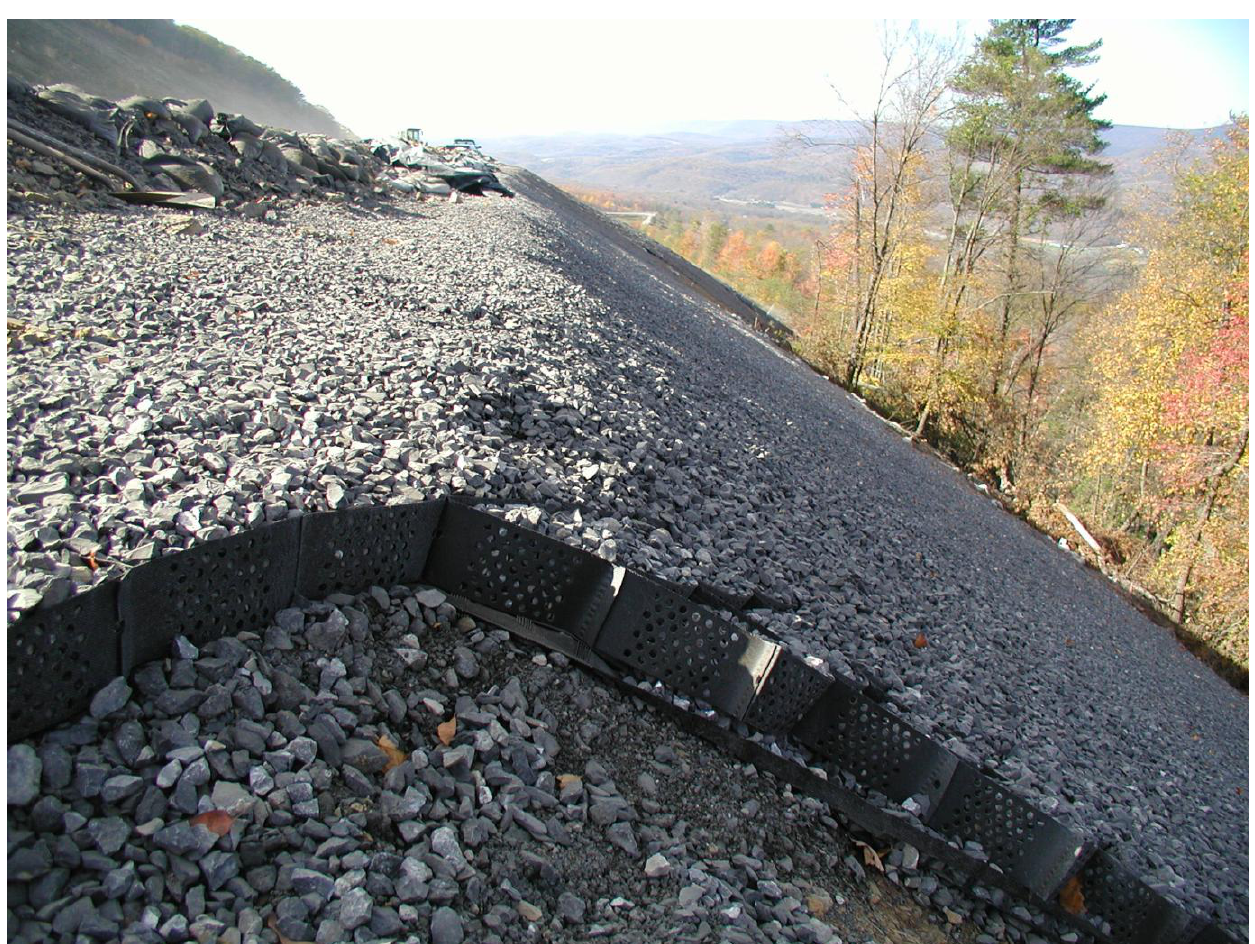
Figure 5. Stone aggregate-filled geocell overlying a geogrid layer. The slope shown varies in inclination from 1H:1V to